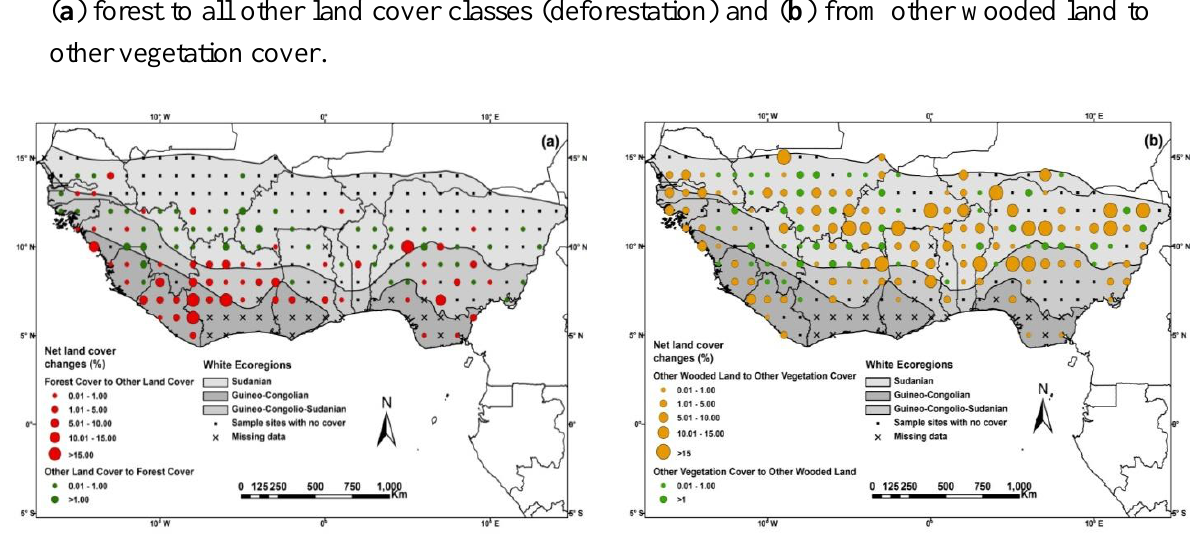
Figure 8. Net land cover changes in West Africa between 1975 and 1990 focused